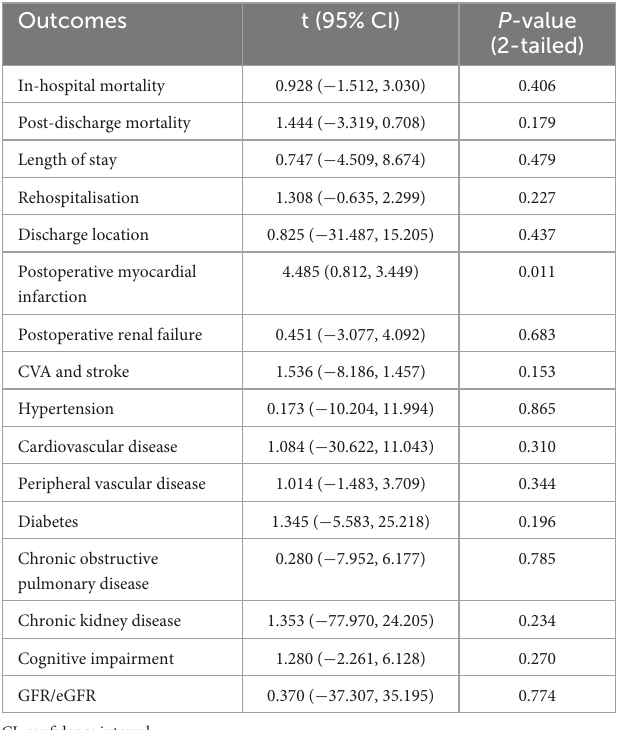
TABLE 7 Egger’s regression analysis on publication bias for included studies on categorical